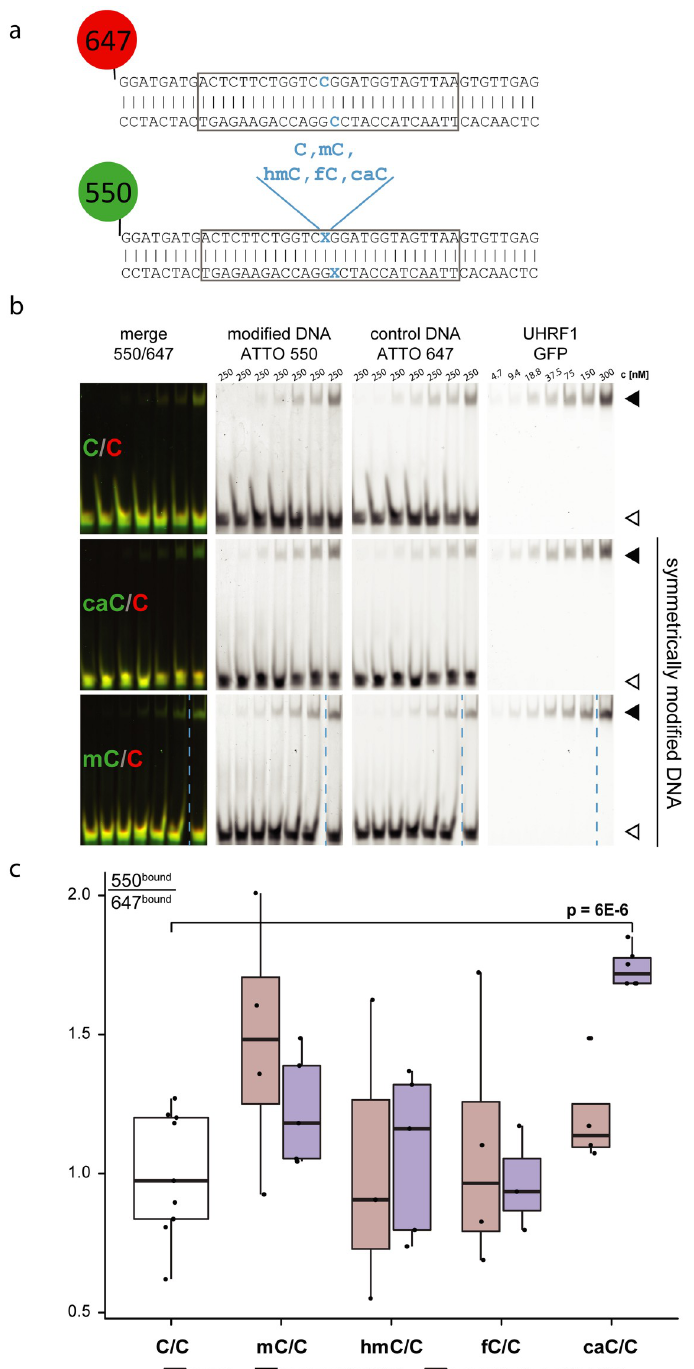
Fig 2. Binding of UHRF1 to differentially modified CpG sites. (a) DNA used in EMSA experiments. The 550-labelled DNA contains a central CG site harbouring different cytosine modifications: Unmodified C, mC, hmC, fC, or caC. The modification resides either on one strand (hemi-modification) or on both strands (symmetric modification). The 647-labelled oligonucleotide is always unmodified and serves as an internal control and reference. Grey boxes indicate sequences of the shorter DNA fragments used in Fig 3. (b) Representative images of EMSAs. Fluorescently labelled DNA oligonucleotides of 42 bp are incubated with GFP-UHRF1 at increasing protein concentrations. Black arrowheads indicate the DNA-protein complex (bound fraction); white arrowheads show free DNA. Dashed blue lines indicate empty gel lanes that have been removed for presentation purposes. (c) Quantitation of the bound fraction of symmetric and hemi-modified DNA incubated with wild type UHRF1, p value of two-tailed student’s t-test.